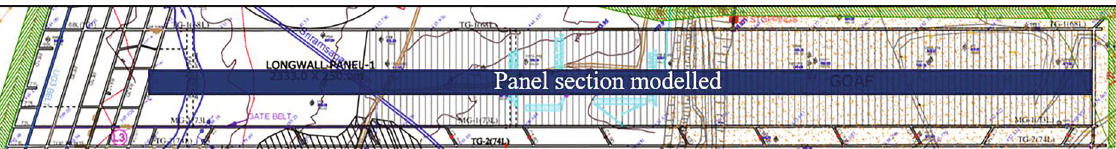
Figure 4: Stratigraphic sequence of ALP.